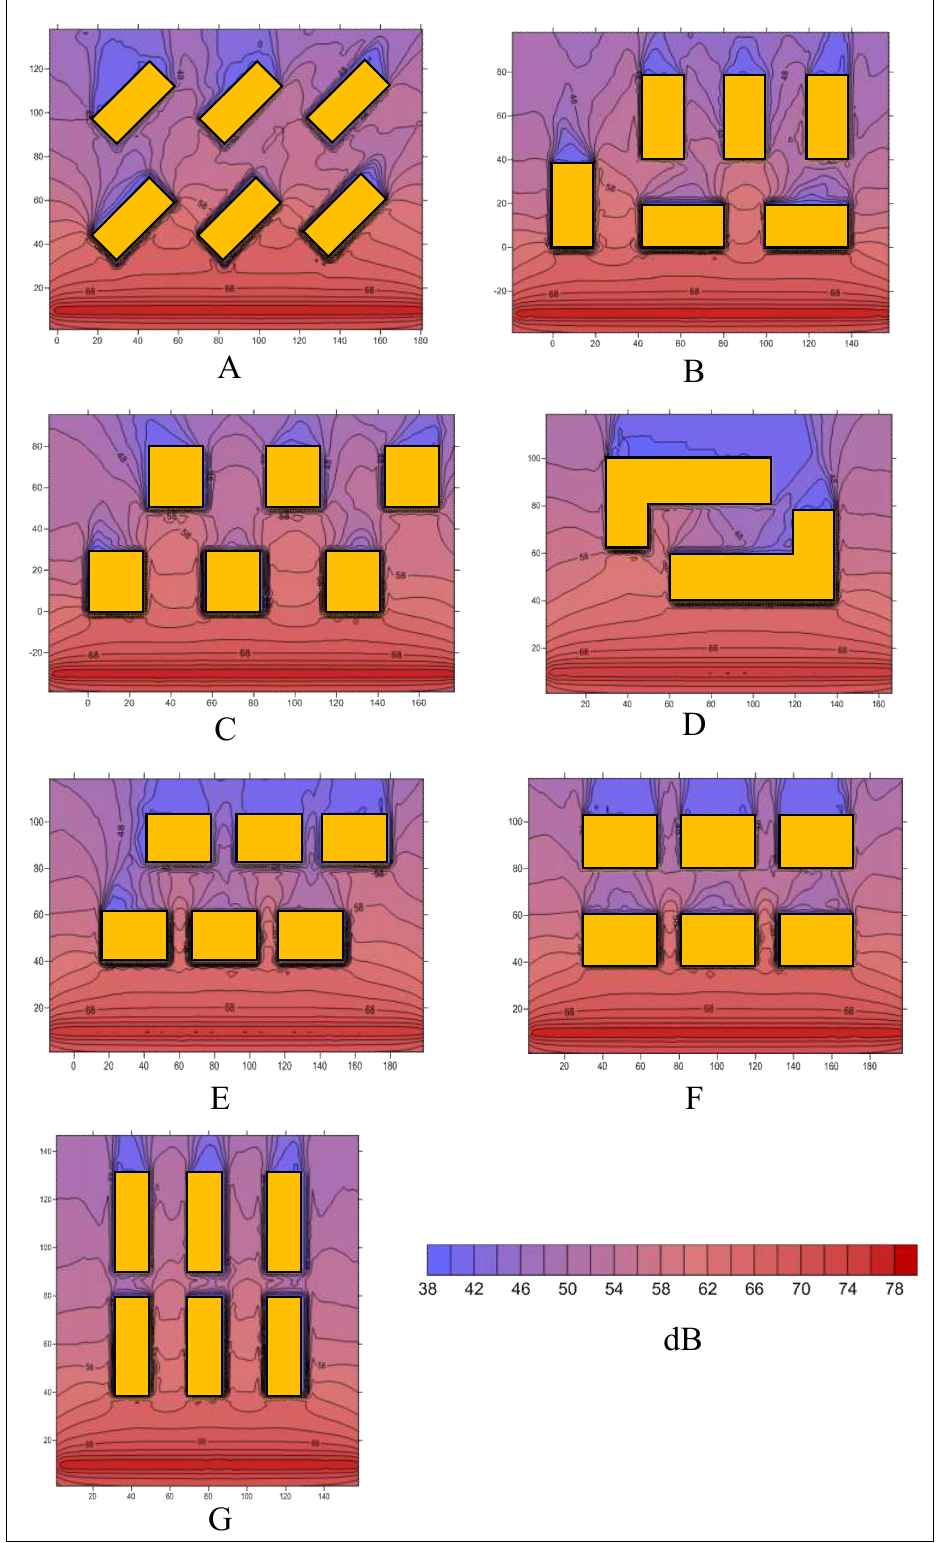
Figure 7. Noise distributions of seven patterns at an 8-m-high plane. ( a ) Pattern A; ( b ) Pattern B; ( c ) Pattern C; ( d ) Pattern D; ( e ) Pattern E; ( f ) Pattern F; ( g ) Pattern G.